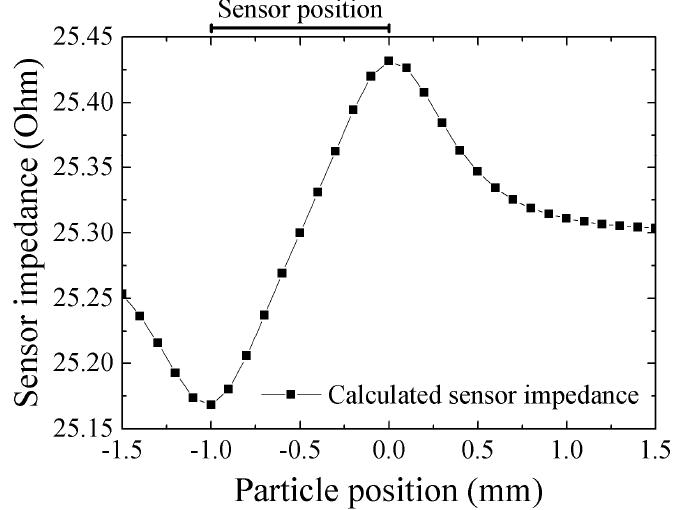
Figure 26. Result of numerical estimation of sensor impedance as a function of particle position [21].